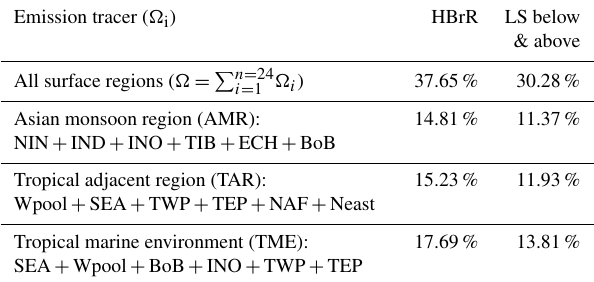
Table 5. The air mass contributions of the CLaMS surface emission tracers (defined in Fig. 9) in the HBrR and the LS below and above the HBrR (shown in Fig. 11c–d respectively). The HBrR is between equivalent latitudes 55 − 80 ◦ N and (cid:50) = 350–385K, while the LS below and above is between equivalent latitudes 55 − 80 ◦ N from the TP to (cid:50) = 350K and (cid:50) >